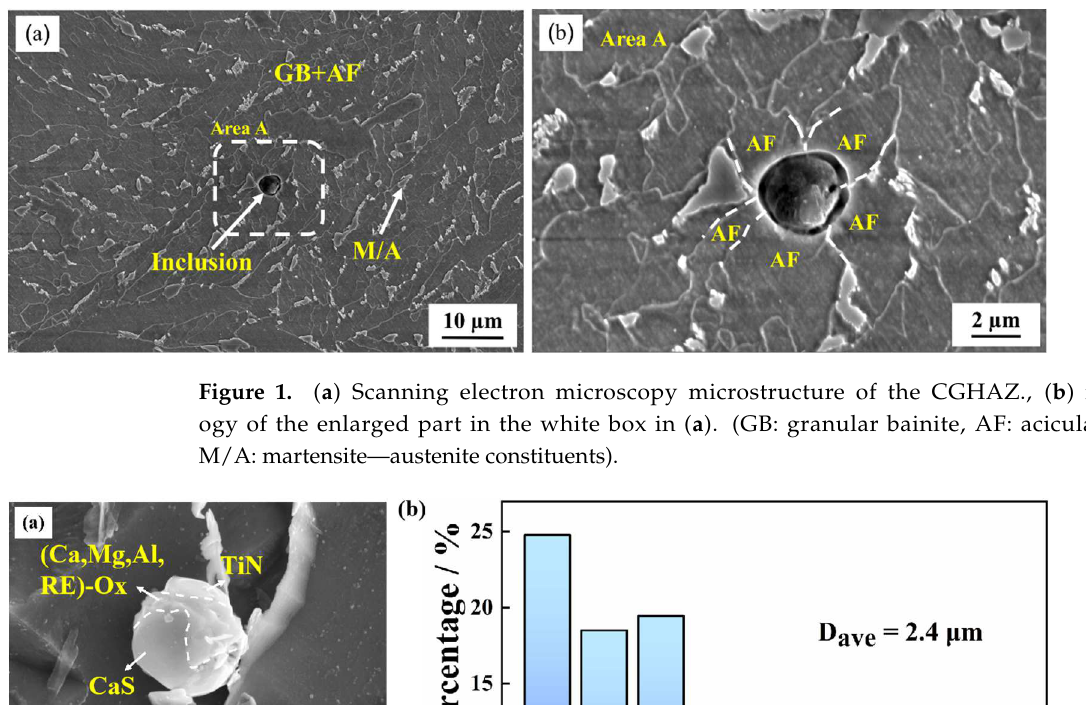
Figure 1. ( a ) Scanning electron microscopy microstructure of the CGHAZ., ( b ) m orphology of the enlarged part in the white box in ( a ). (GB: granular bainite, AF: acicular ferrite, M/A: martensite– austenite constituents)